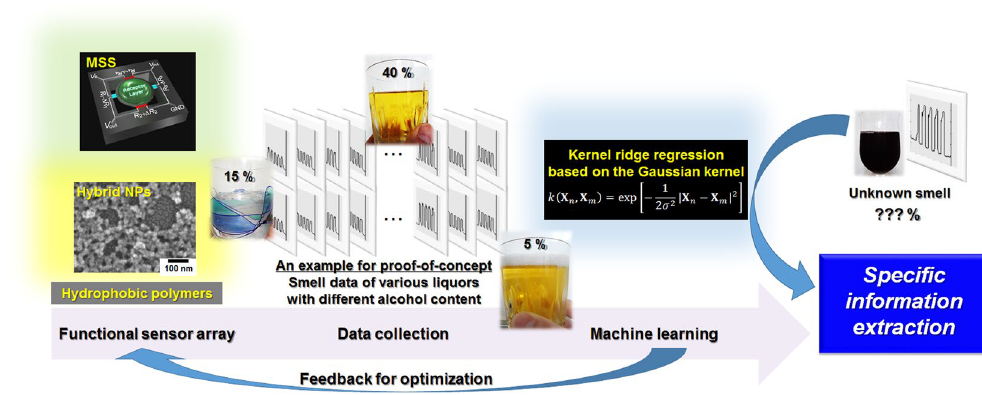
Figure 1. A concept of the present study. Note that the alcohol content is just an example of the specific information for a